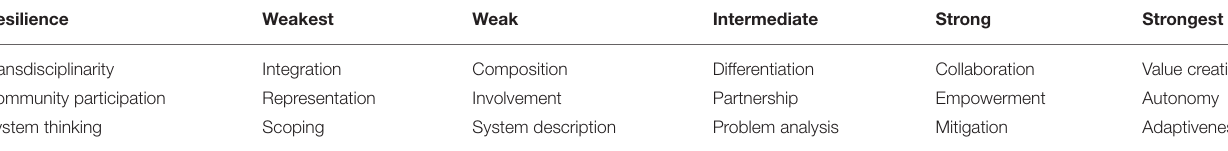
TABLE 1 | Dimension of resilience containing sequential criteria of progressing